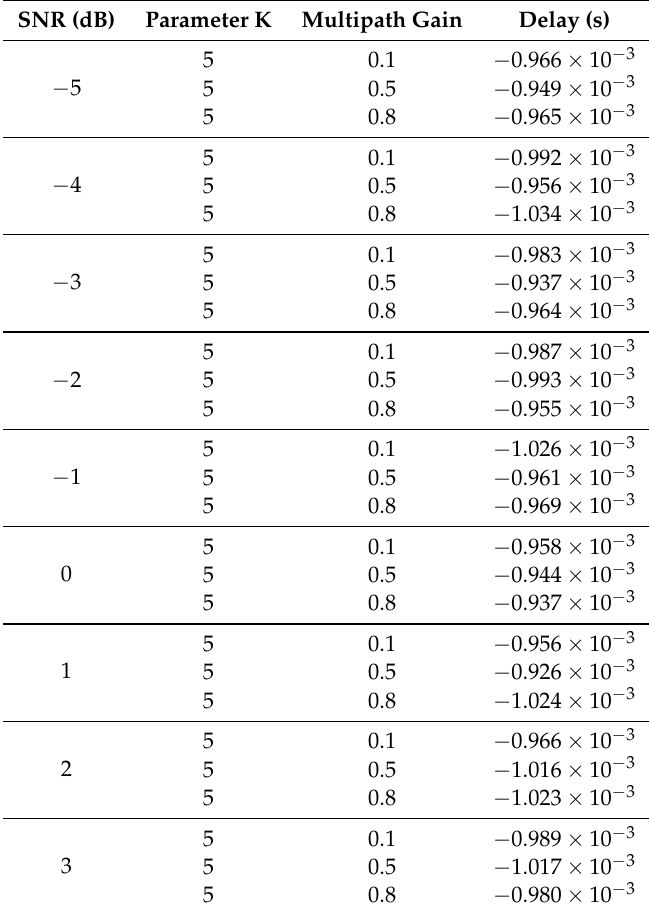
Table 1. LMSTDE Delay Estimation with Multipath Gain